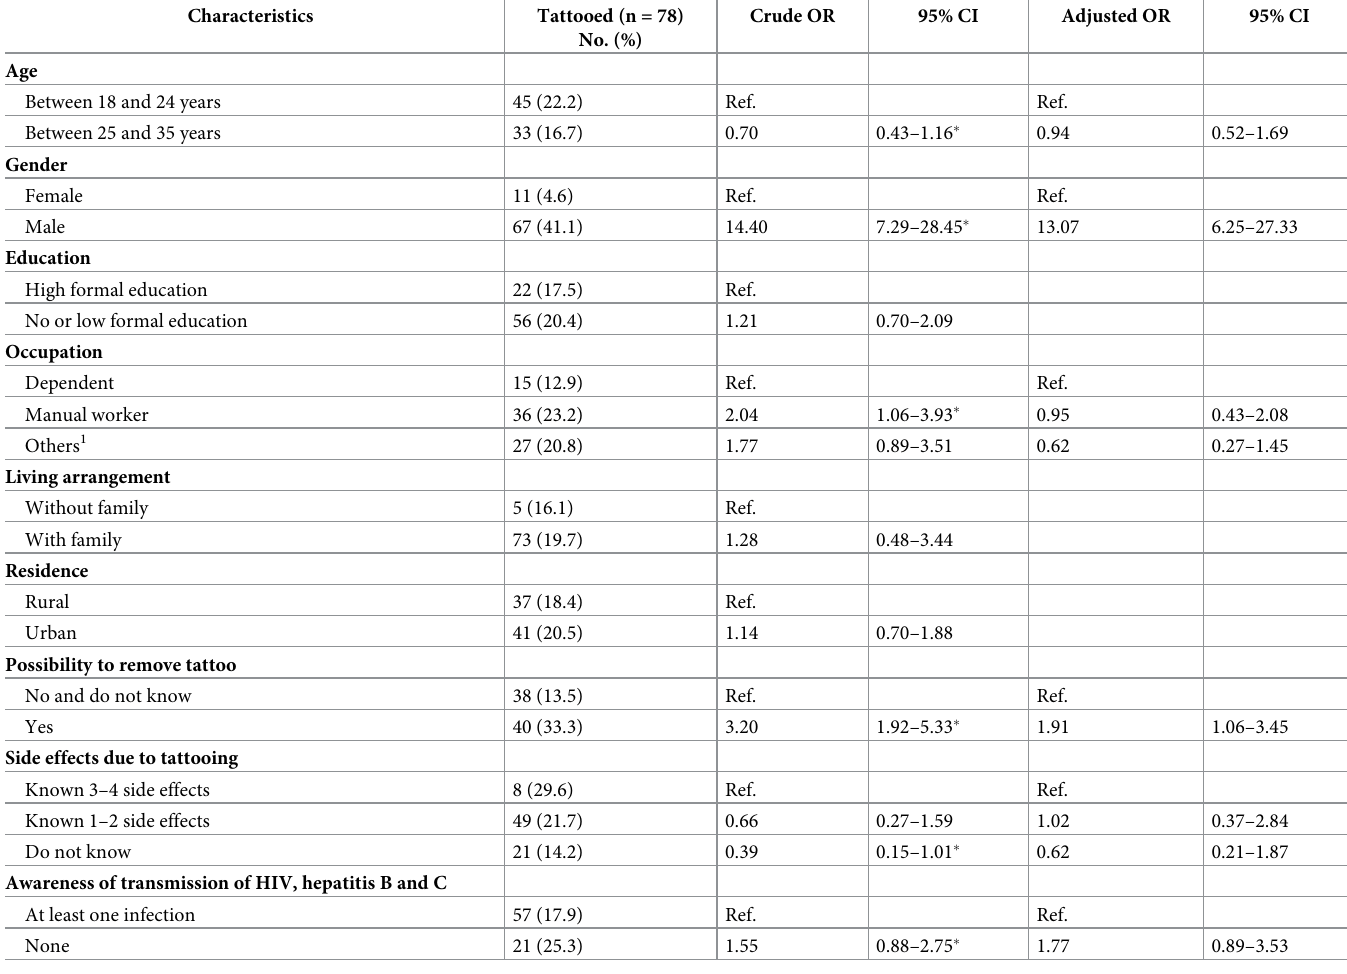
Table 3. Factors associated with tattooing practice among adults, Mandalay Region, 2015 (n = 401).